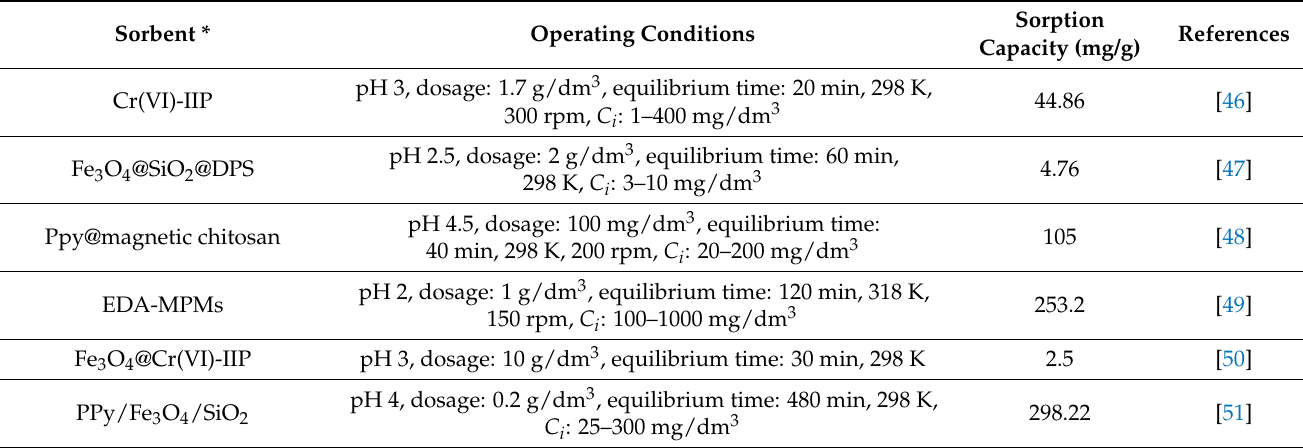
Table 4. Comparison of chromium sorption capacity of various magnetic sorbents.